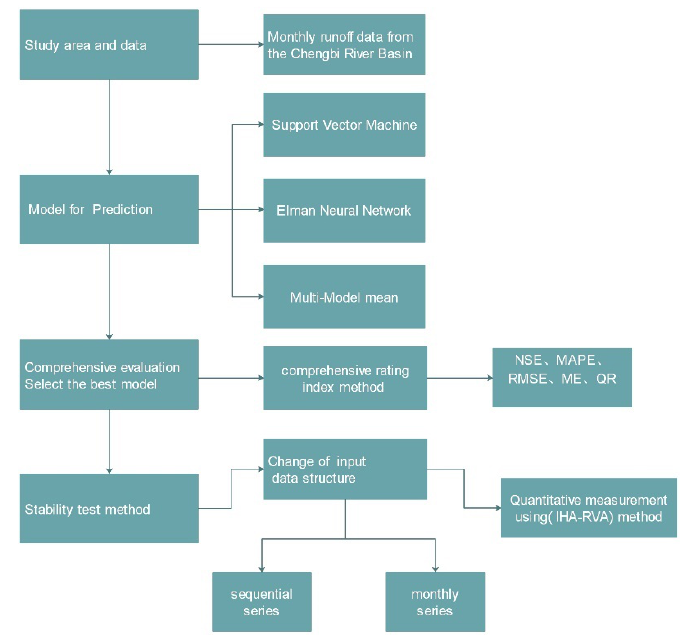
Figure 1. Flowchart of the research.